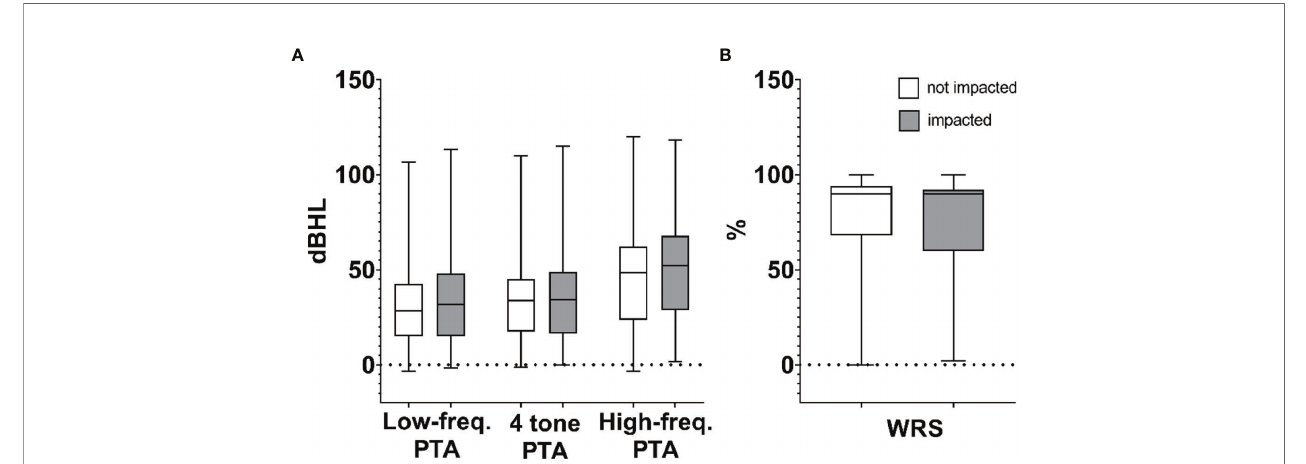
FIGURE 3 | Composite box plots demonstrating patient audiometric data for non-impacted and impacted tumors calculated as (A) high-frequency pure tone average (PTA), speech-frequency (4-tone) PTA, low-frequency PTA, and (B) word recognition score (WRS). Within each box, horizontal lines denote median values; boxes extend from the 25 th to the 75 th percentile of each group ’ s distribution of values; vertical extending lines denote adjacent values (i.e., the most extreme values within 1.5 interquartile range of the 25 th and 75 th percentile of each